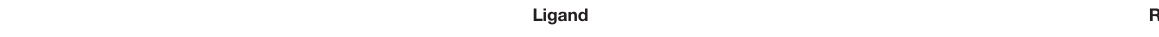
TABLE 3 | Various PRRs and their ligands. PRR